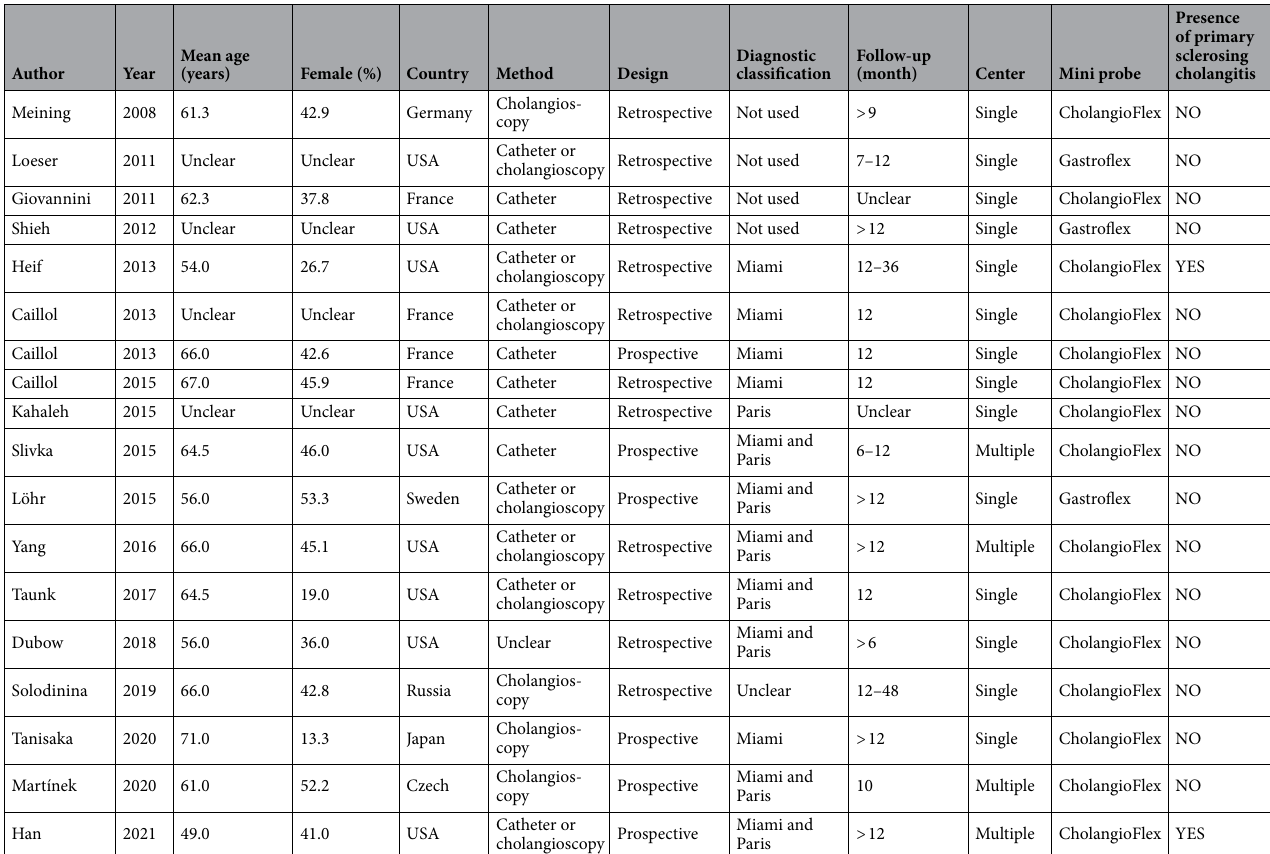
Table 1. Characteristics of the selected